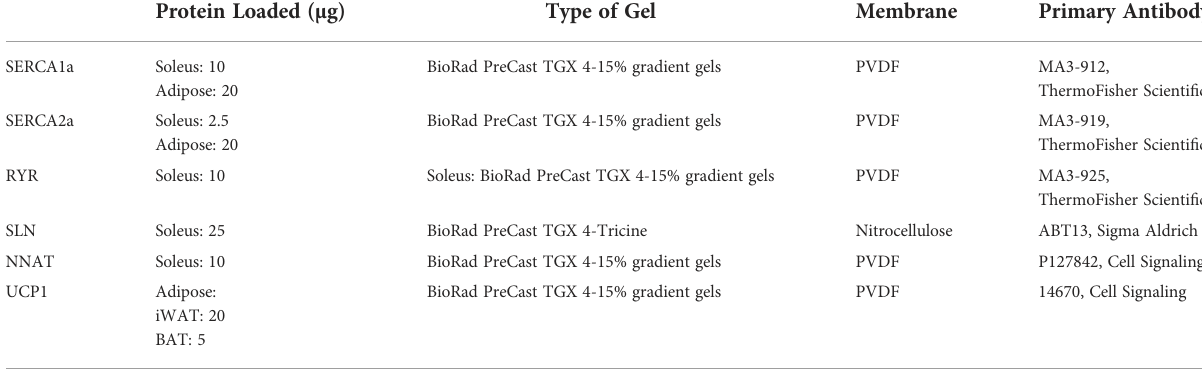
TABLE 1 Western blotting electrophoresis and antibody